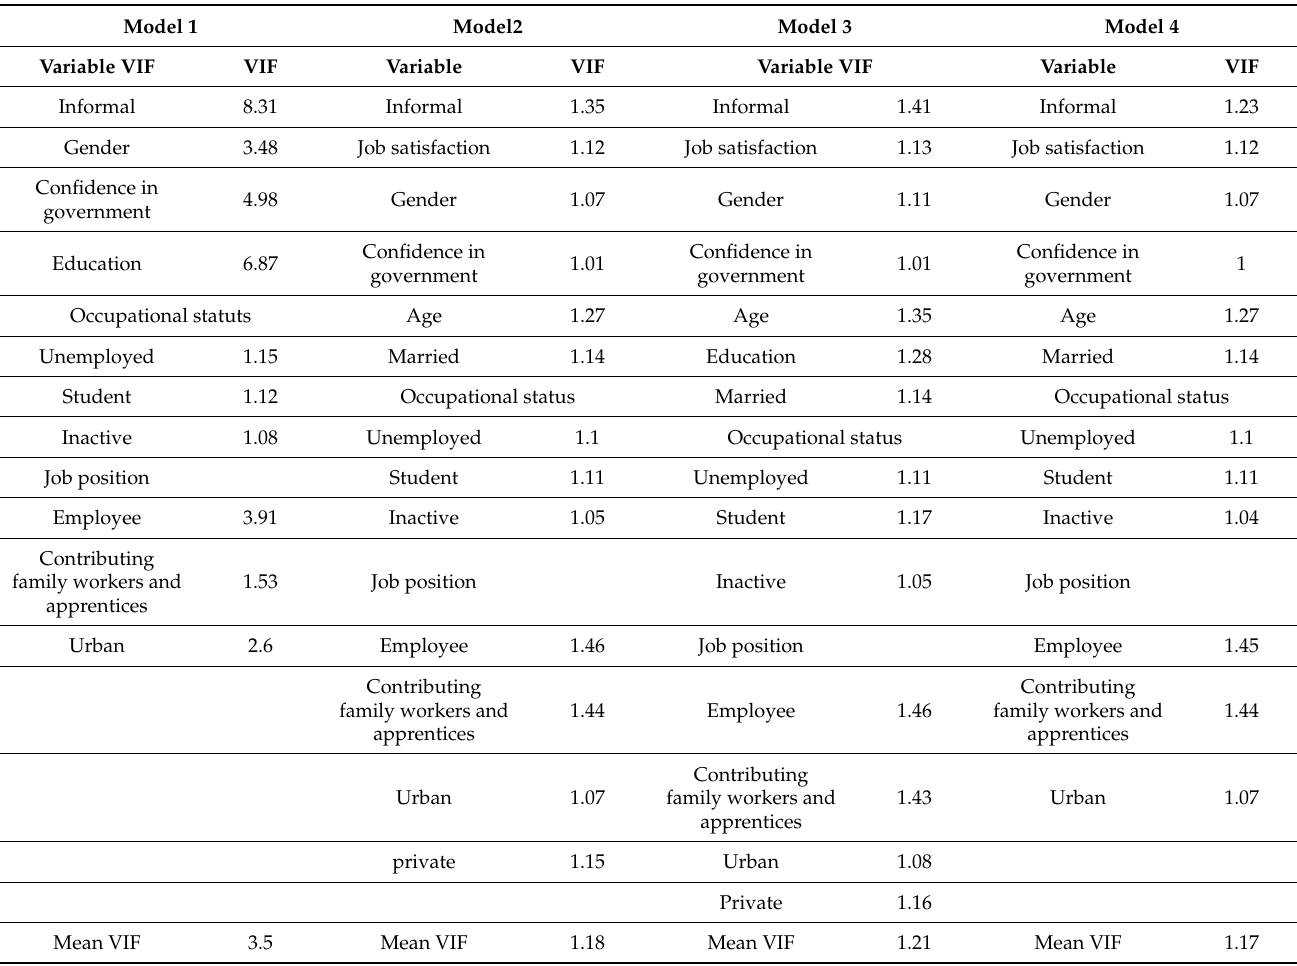
Table A1. Test of multicollinearity.